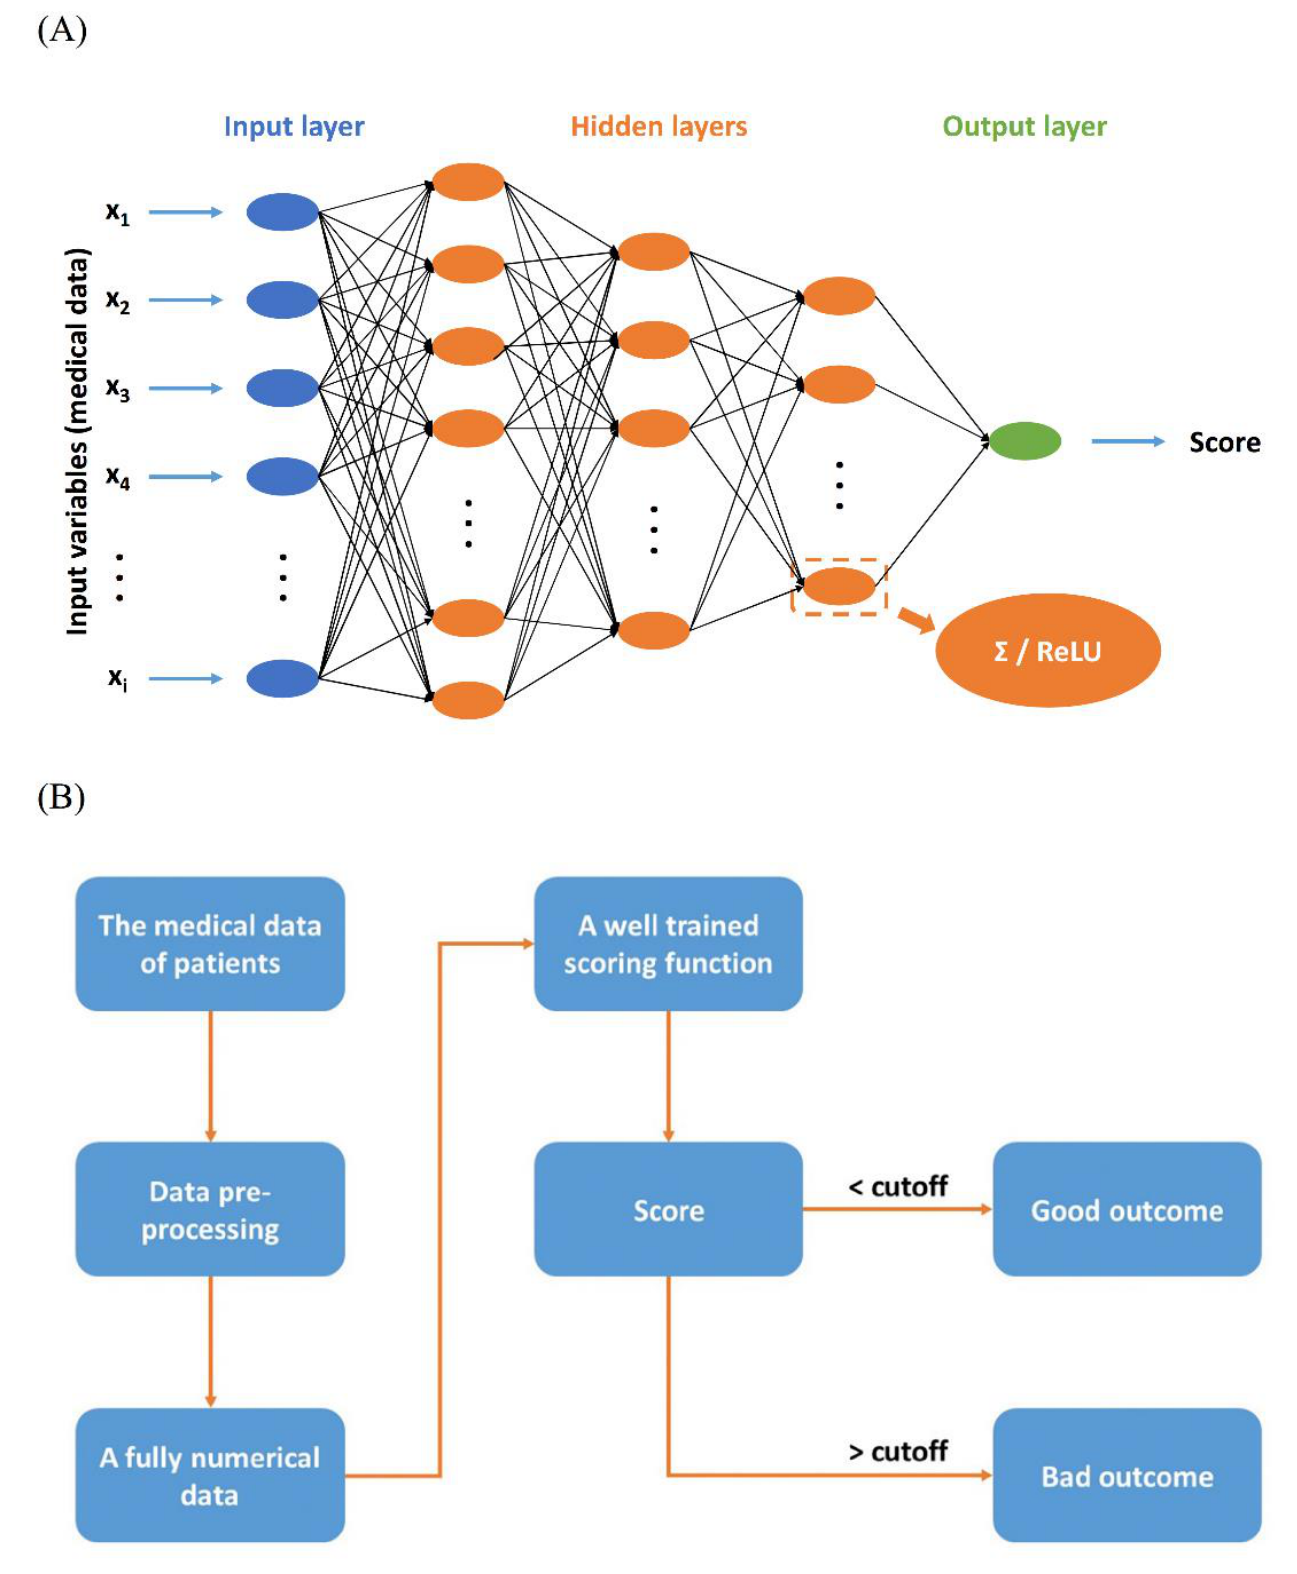
Figure 1. ( A ) Diagram of the deep neural networks multivariate regression model. ( B ) Diagram of the whole assay procedure. (ReLU: a rectified linear unit)